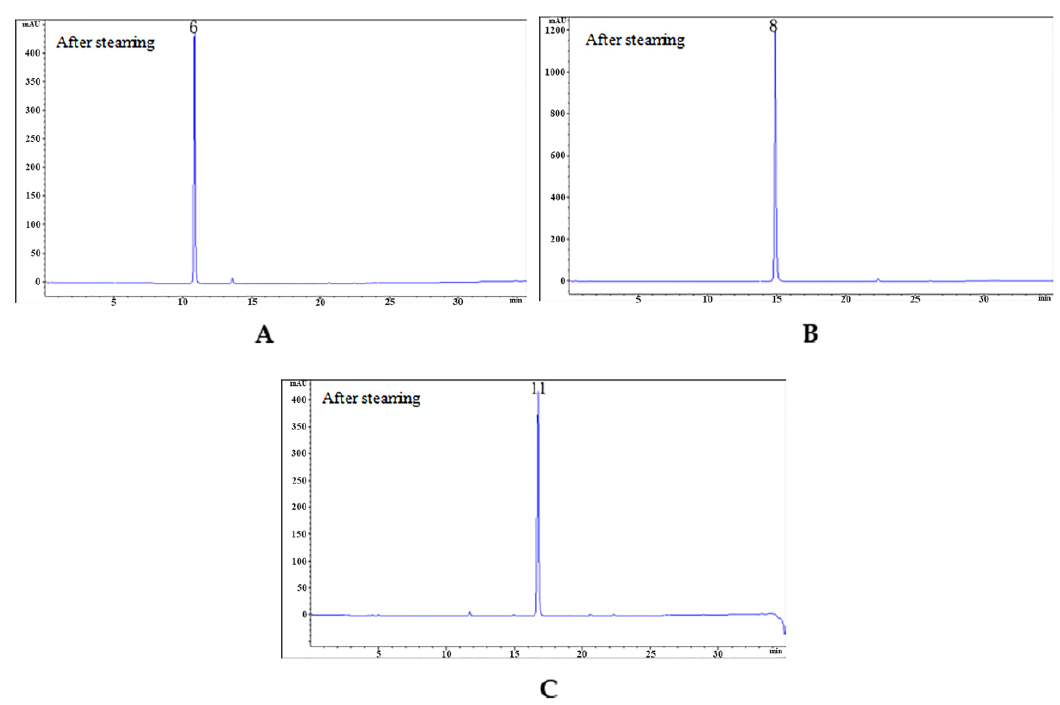
Figure 7. The HPLC chromatograms of GAS ( A ), HBA ( B ), S -(4-hydroxybenzyl)glutathione ( C ) after hydrolysis.